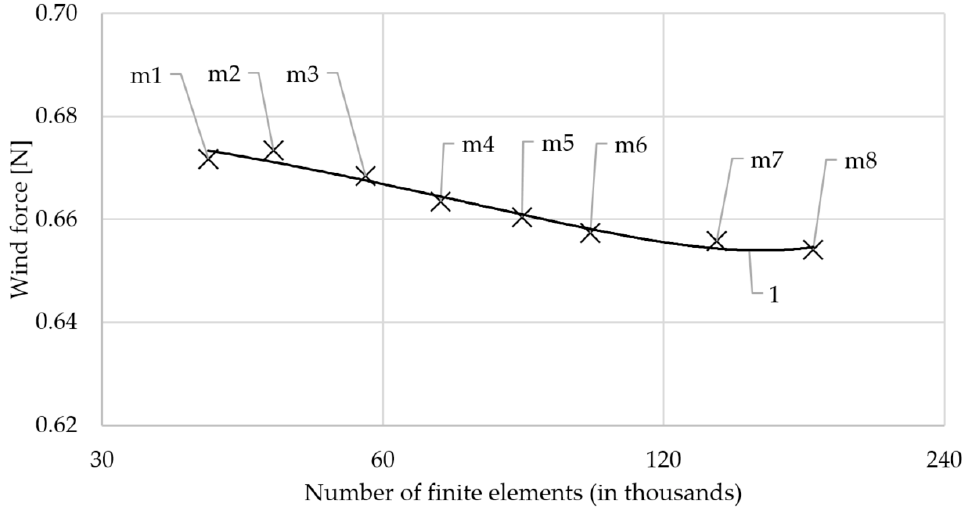
Figure 8. Mesh validation results based on case c5: (1) polynomial approximation of wind force for different mesh quality (m1–m8).